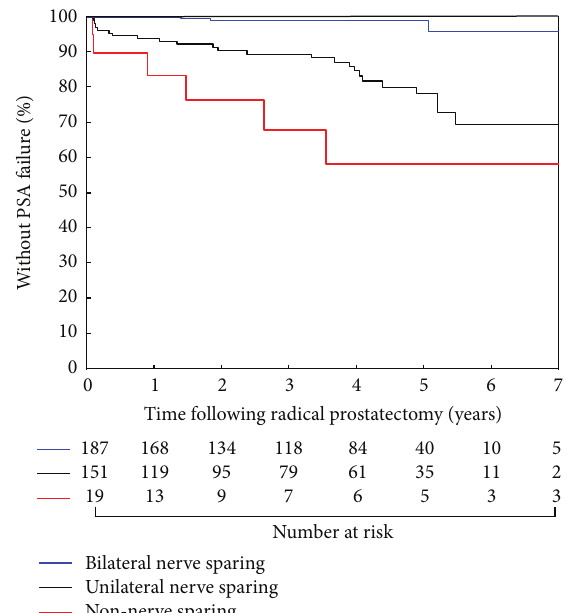
Figure 1: PSA failure-free survival following radical prostatectomy, stratified by whether one, both, or neither nerve was